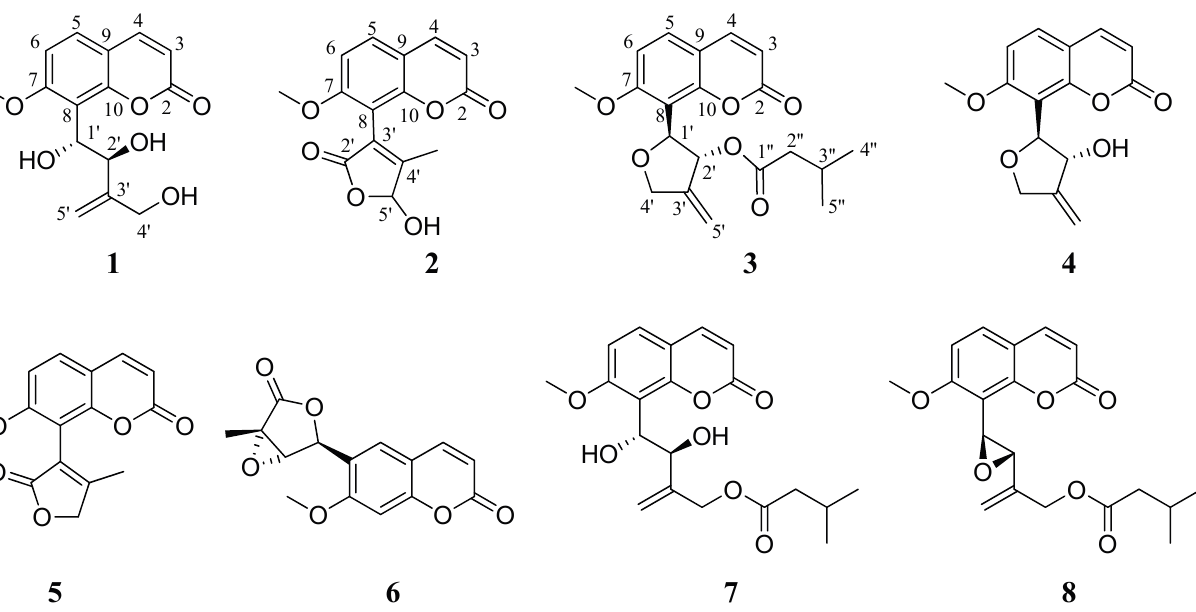
Figure 2. Structures of compounds 1 – 8